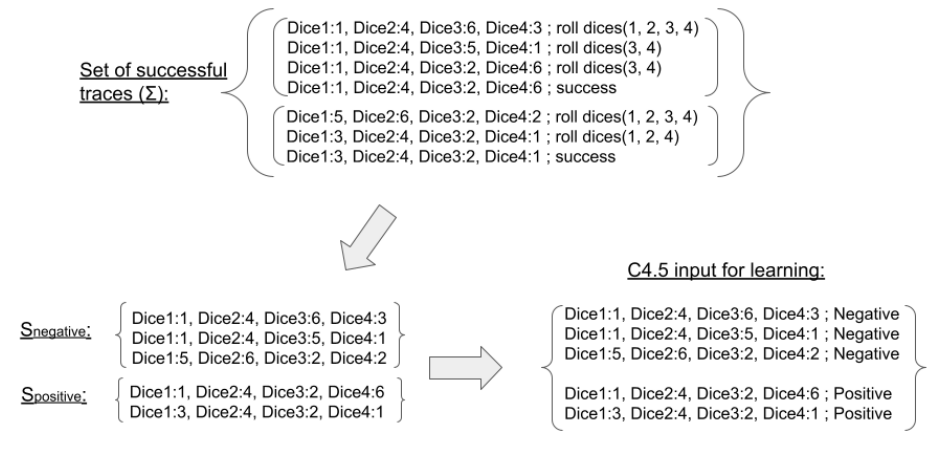
Figure 1. Illustration of C4.5 learning setup with our model.